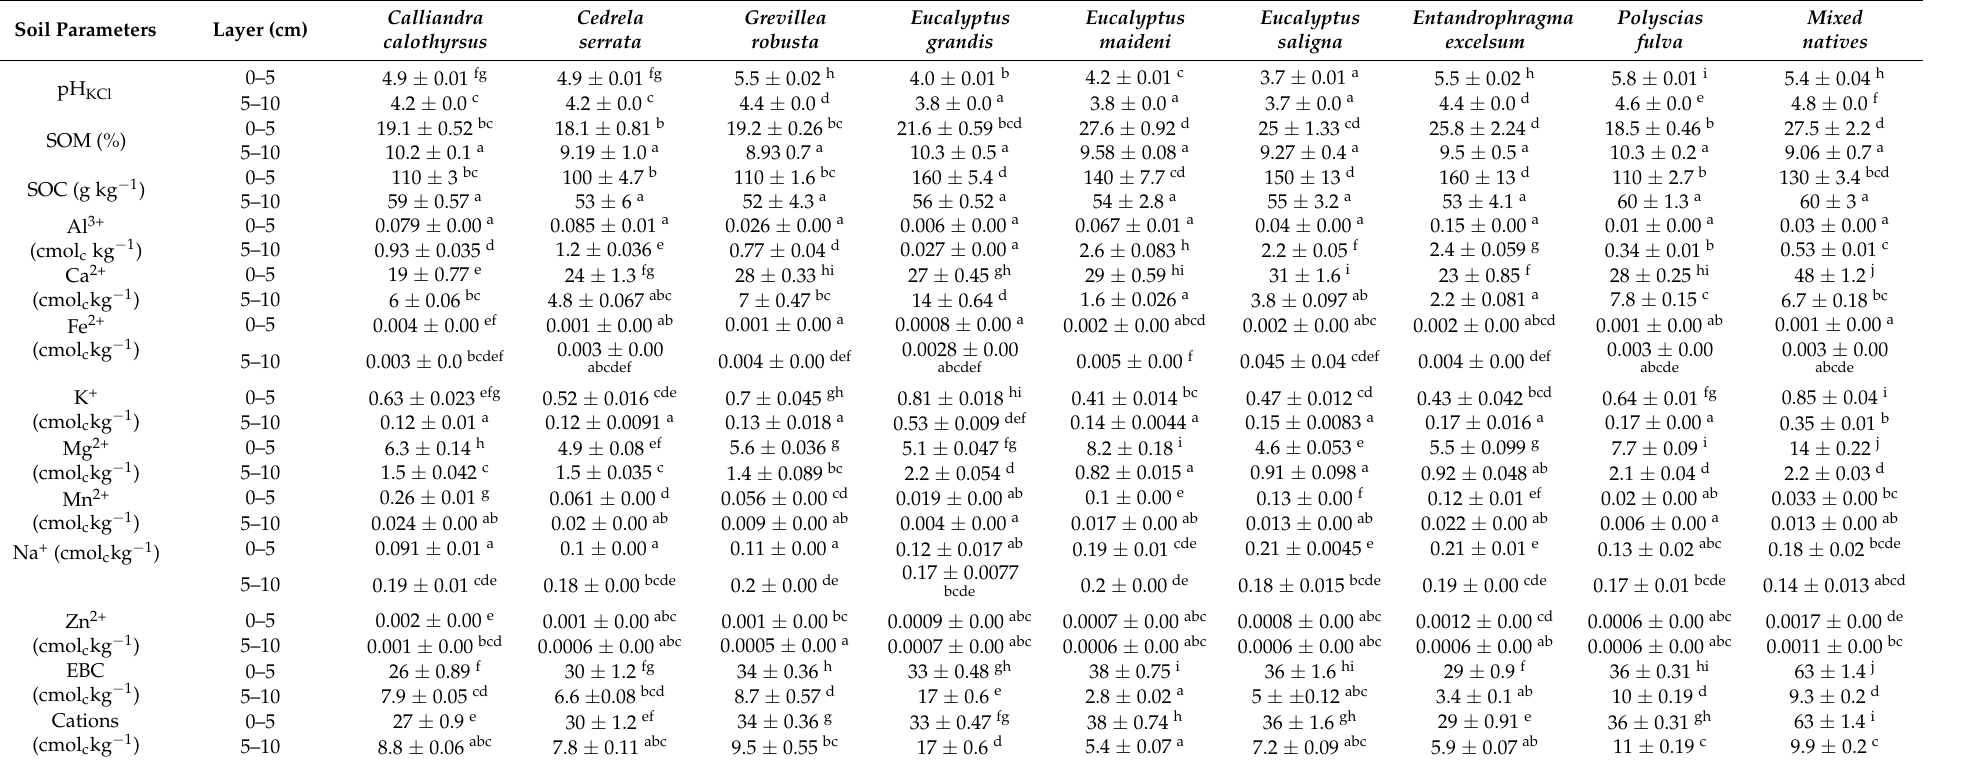
Table A3. Measured soil characteristics under different tree species in the Arboretum of Ruhande (means ± SEM). Different letters within one parameter denote significant differences between tree species and soil depths (mixed linear models, Tukey’s HSD, p < 0.05 (Rwibasira et al., Long-term effect of forest plantation species on soil chemical properties in Southern